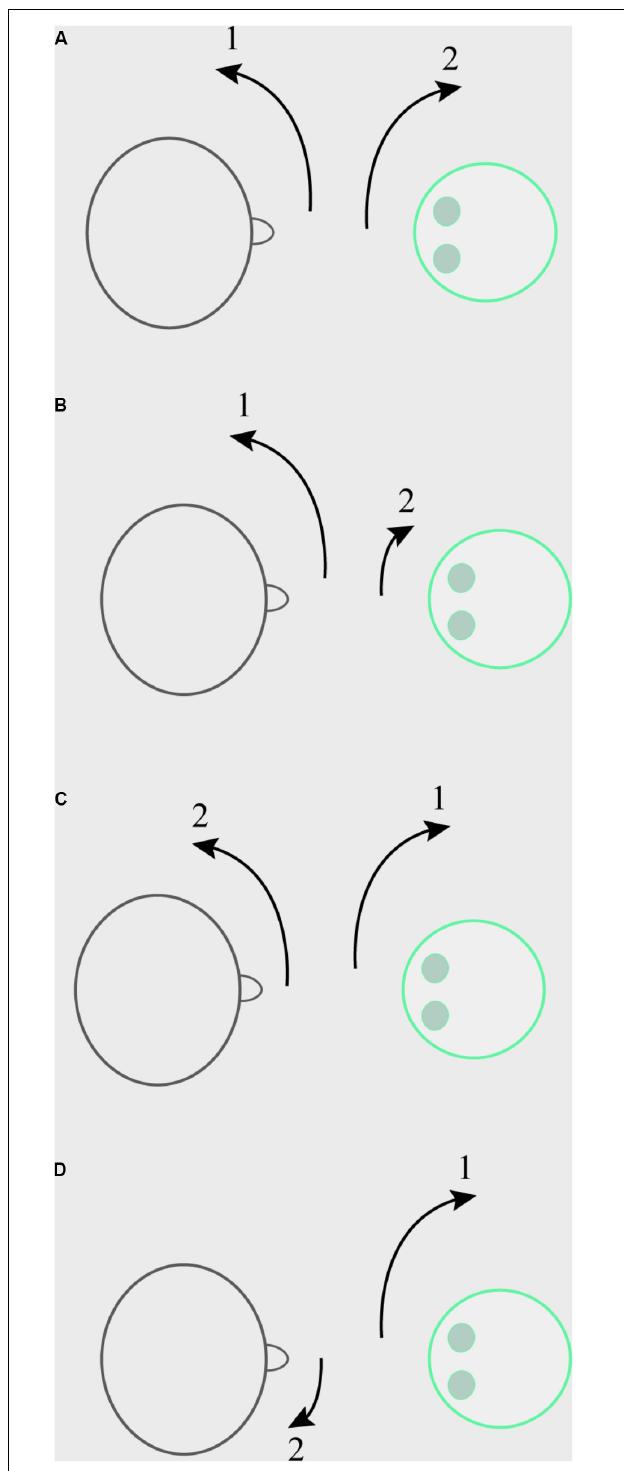
FIGURE 1 | Example of the Synchrony manipulation. (A) Human initiator, synchronous condition. The participant (on the left) initiates a large head movement to the left, the robot (on the right) synchronizes with this with a minimal delay by making a large head movement to the right. (B) Human